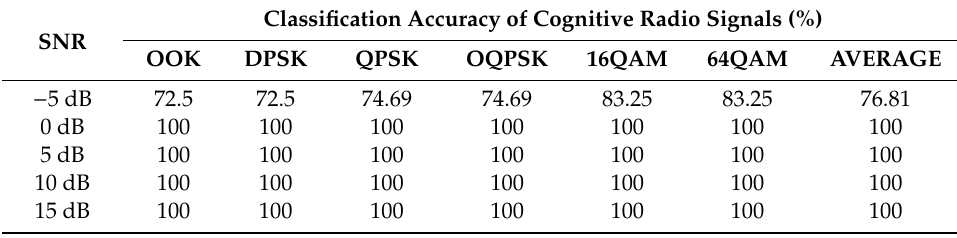
Table 6. The classification accuracy of the cognitive radio signals using multidimensional HOC, cyclic spectrum and DT–SVM classifier. Classification Accuracy of Cognitive Radio Signals (%) SNR OOK DPSK QPSK OQPSK 16QAM